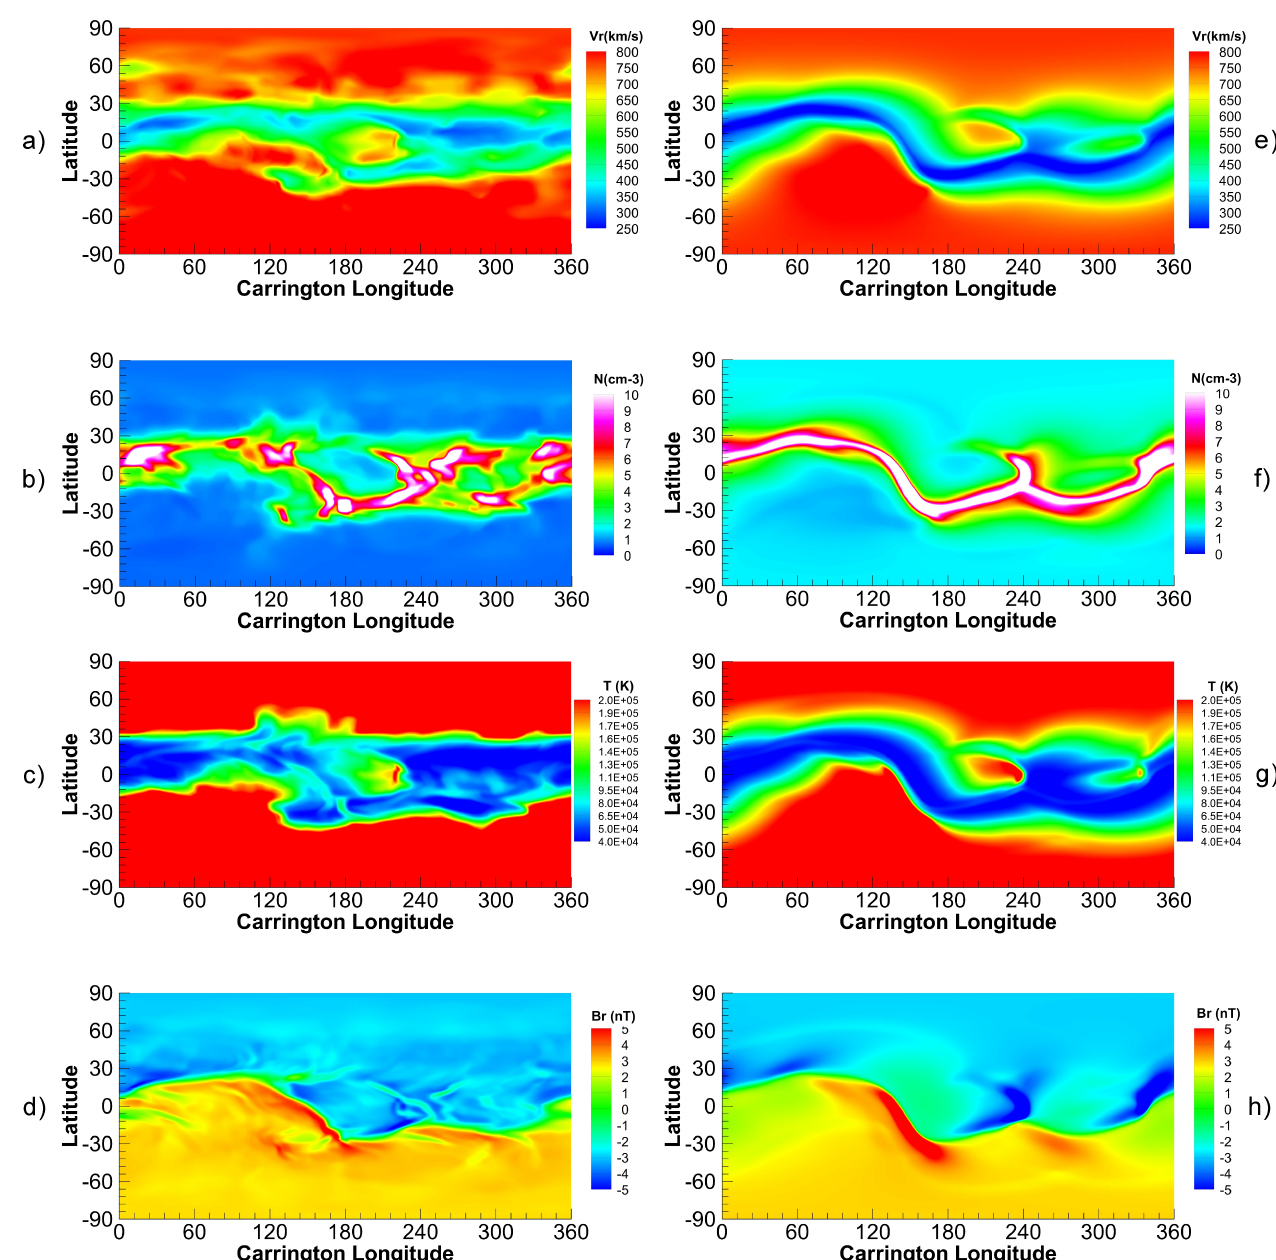
Figure 5. Modeling results of the global distribution of ( a ) velocity (Vr), ( b ) density (N), ( c ) temperature (T) and ( d ) radial magnetic field (Br) at 1AU during CR2062 from the new MHD model driven by multiple observations and ANN, and the modeling results of ( e ) Vr, ( f ) N, ( g ) T, and ( h ) Br from our previous MHD model only based on the WSA model. The x axis is the Carrington longitude, and the y axis is the